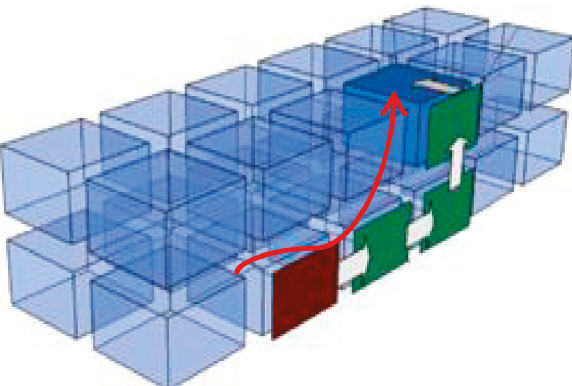
Figure 6: Nonprimary energy transfer paths between